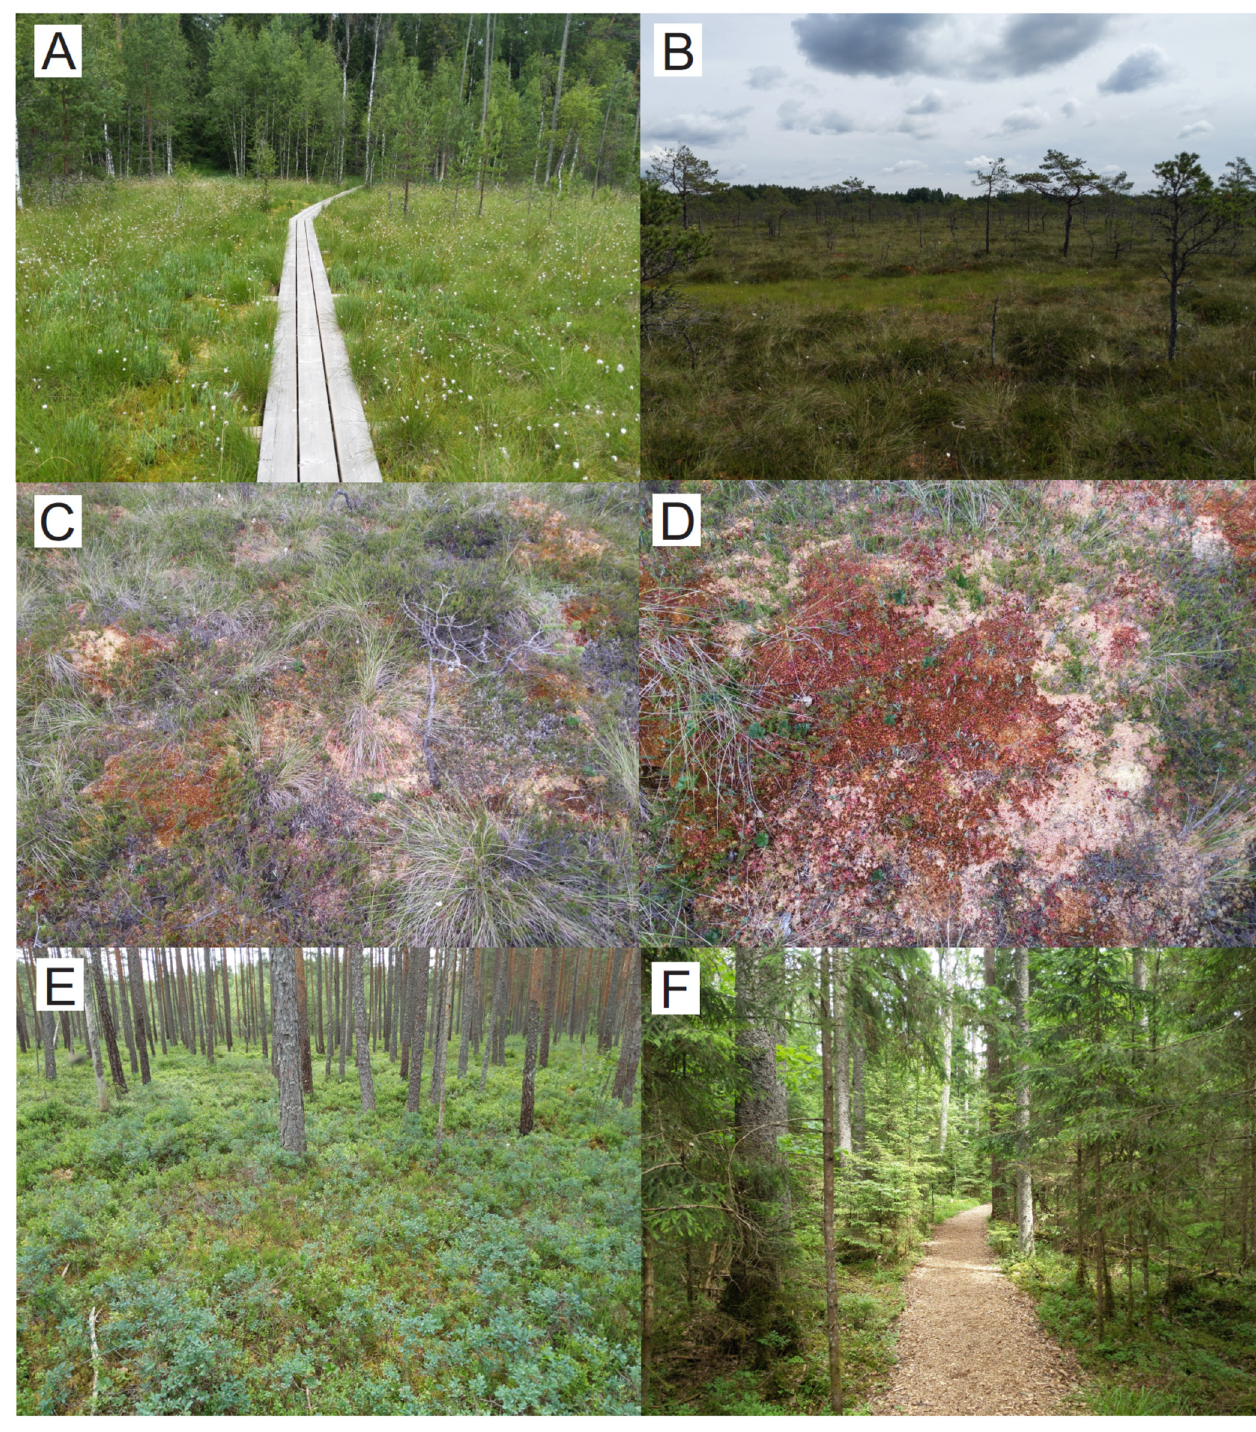
Figure 2. Typical vegetation at Teringi Bog and the surrounding margins. Panel ( A ) represents the boundary between the open bog and forest. Panels ( B – D ) are at the coring location in the center of the bog (see Figure 1). Panel ( E ) represents trees growing near the center of the bog. Panel ( F ) is the forest on the western edge of Teringi. Estonia has a temperate climate that is transitional between oceanic and continental, with changes in North Atlantic Ocean-driven circulation dynamics affecting the environ- mental conditions of the region [26,27]. Stronger westerly zonal winds deliver warmer ocean air to the interior, causing warmer temperatures, while weaker circulation causes colder conditions [28]. The majority of moisture is sourced from the Atlantic Ocean while the Mediterranean Sea and Black Sea provide small secondary sources [29]. The Baltic Sea